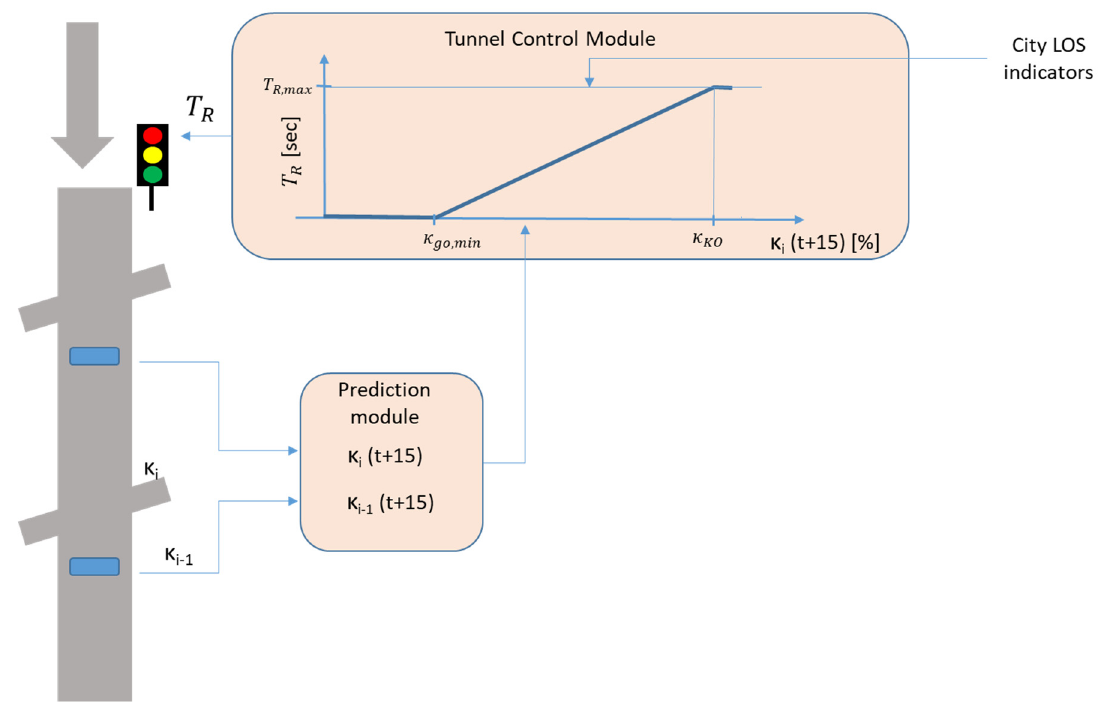
Figure 13. Schematic depiction of the road urban tunnel traffic control algorithm.